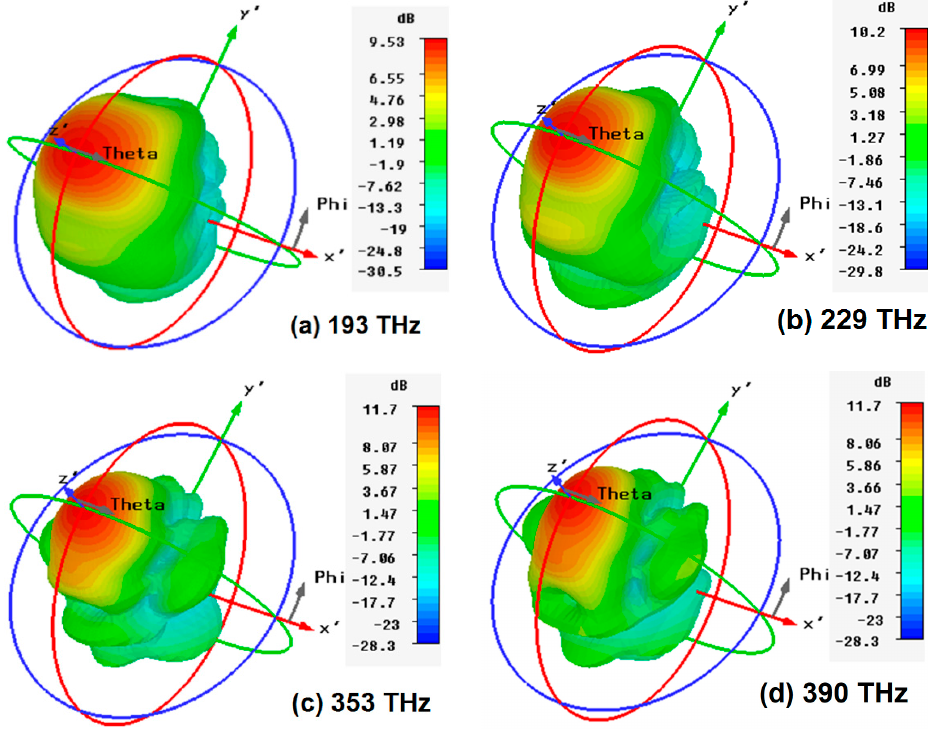
Figure 17. The 2 × 1 array 3D far field gain pattern at ( a ) 193 THz; ( b ) 229 THz; ( c ) 353 THz; ( d ) 390 THz.